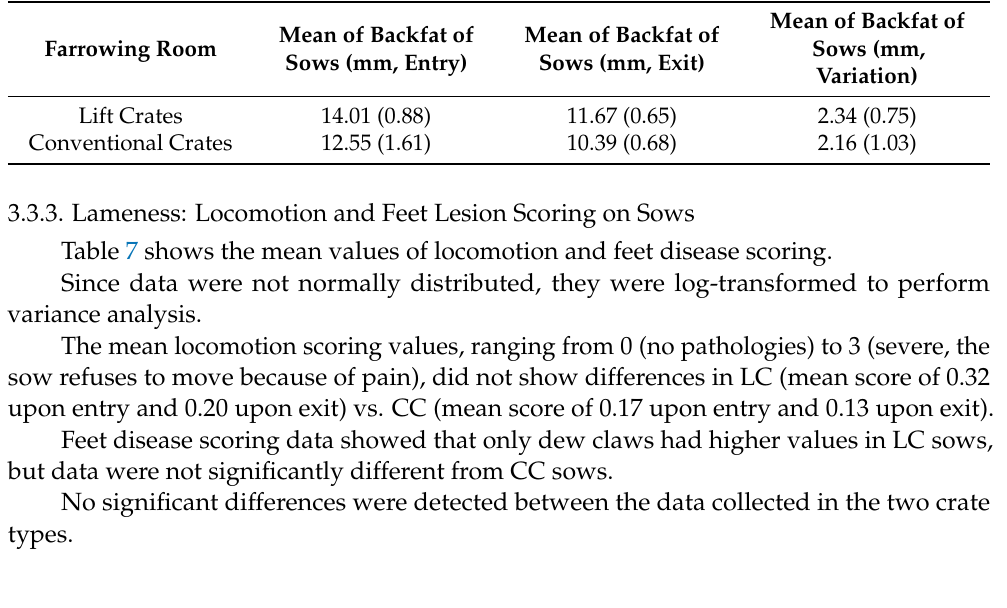
Table 6. Backfat thickness values measured in the back area, at point P2 of the rib, 6–7 cm lateral to the dorsal